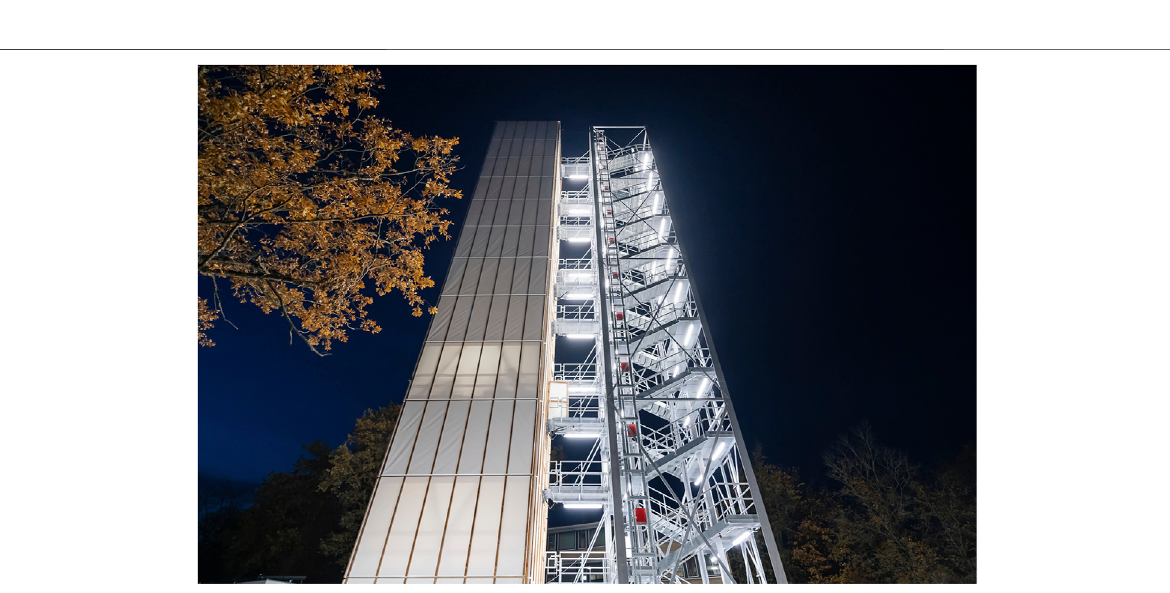
Frontiers in Built Environment |